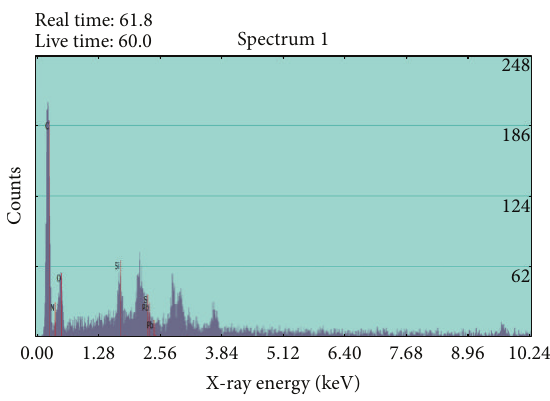
Figure 6: EDX elemental analysis.